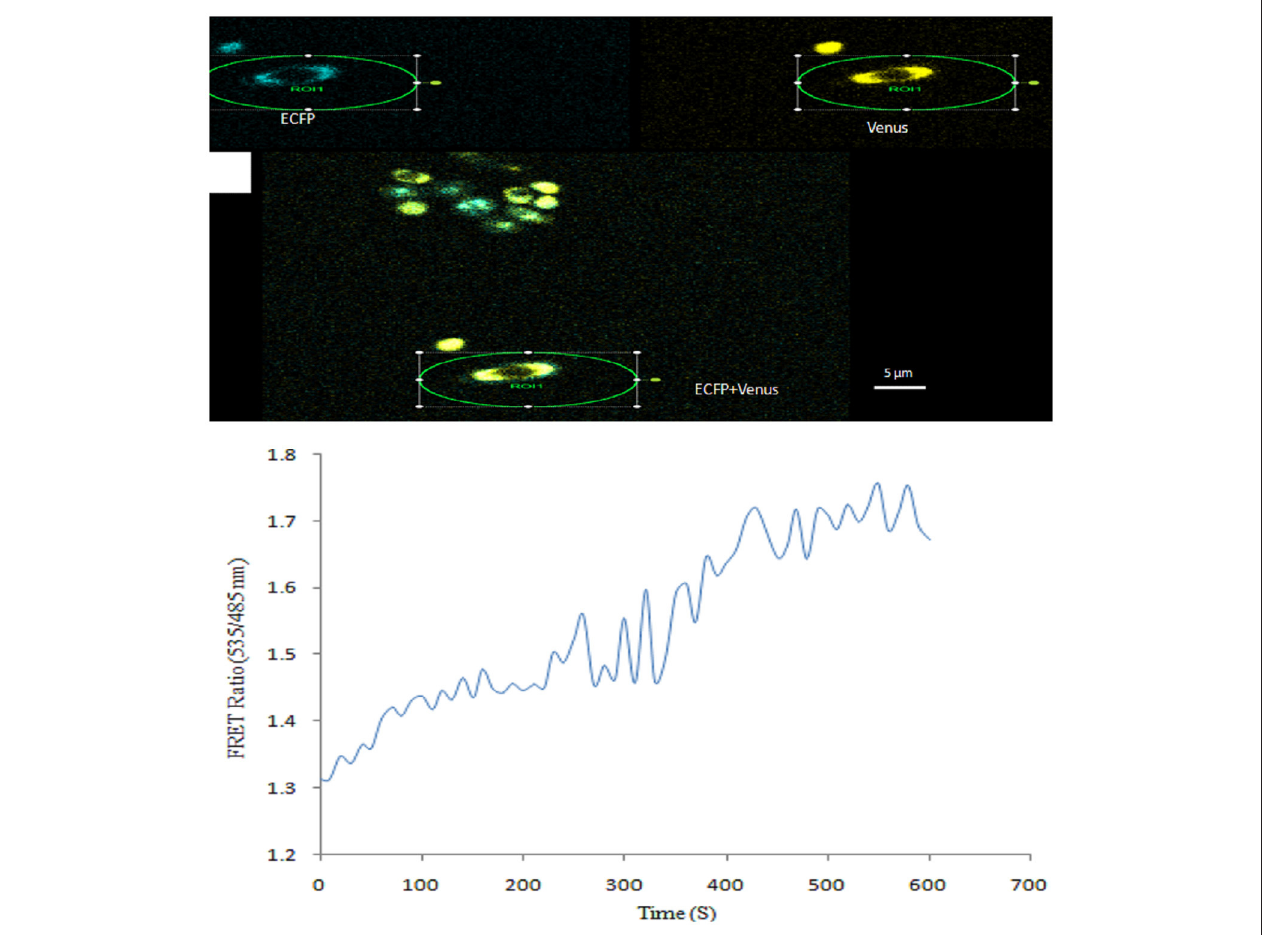
FIGURE 8 | Measurement of NeuAc in yeast cells using FLIP-SA. (A) Yeast cells showing expression of the FLIP-SA sensor in the cytosol (scale bar, 10 µ m). (B) Time-course (0–610s) monitoring of the level of NeuAc in yeast cells by FLIP-SA after the addition of